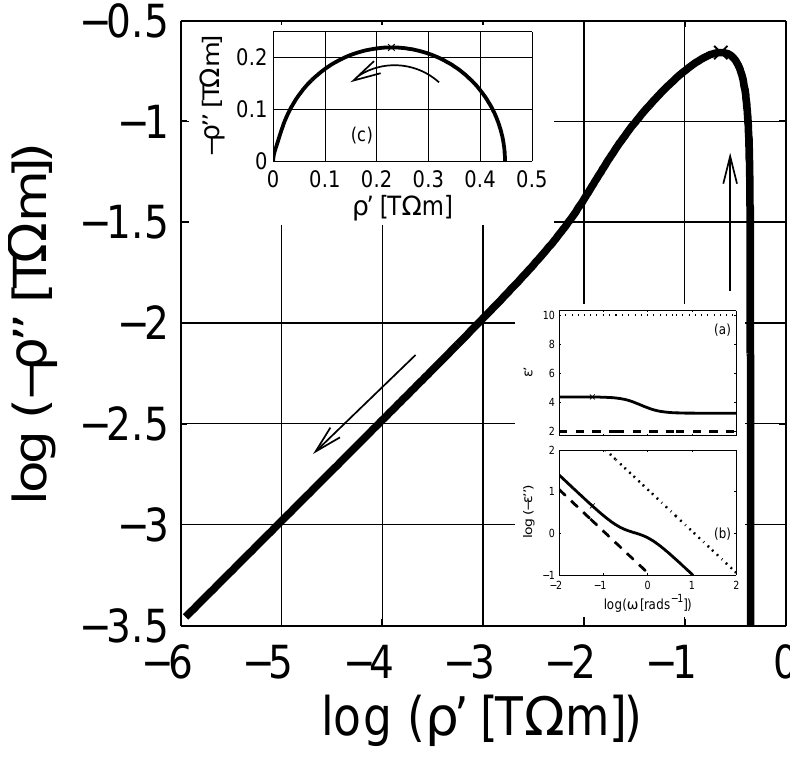
Figure 1 . The Argand diagram of resistivity for a Maxwell Garnett composite in log-log = ε MG ( ω ; ε , ε , 0 . 3 , 3) , with ε = scale, the effective permittivity is calculated with ε e m i m e 2 + 10 − 12 ( ıε ω ) − 1 and ε = 10 + 10 − 10 ( ıε ω ) − 1 . The arrows indicate the direction of 0 i 0 increasing angular frequency ω . Insets (a) and (b) are the real and the imaginary parts of permittivities; ε , ε and ε are the permittivities for the matrix (– – –), inclusion (- - - - -) e m i and effective (——–) media. Inset (c) is the Argand diagram of resistivity in linear-linear scale. Logarithmic scale is base